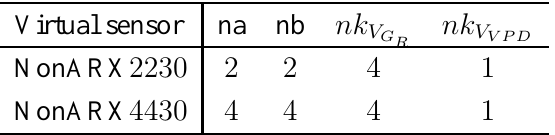
Table 3. Results of the nonlinear virtual sensor calibration: na is the parametric equation’s order of outputs; nb is the order of the input; and nk is the delay of the solar radiation ( nk ) and of the vapor pressure deficit ( nk V G R